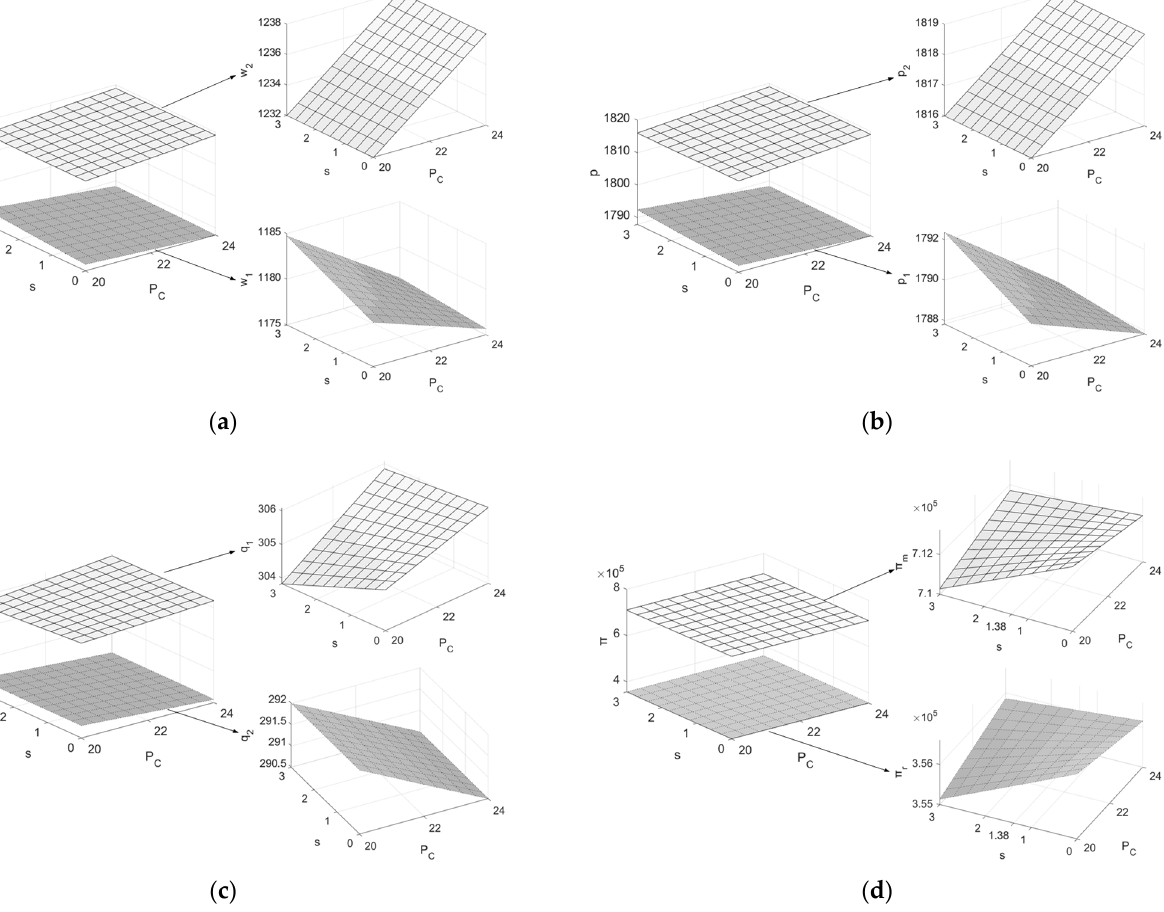
P s Figure 3. Effects of P C and s on decision variables. ( a ) Effects of P C and s on w 1 , w 2 ; ( b ) effects of P C Figure 3. Effects of C and on decision variables. ( a ) Effects of C and s on p 1 , p 2 ; ( c ) effects of P C and s on q 1 , q 2 ; ( d ) effects of P C and s on π m , π r , π